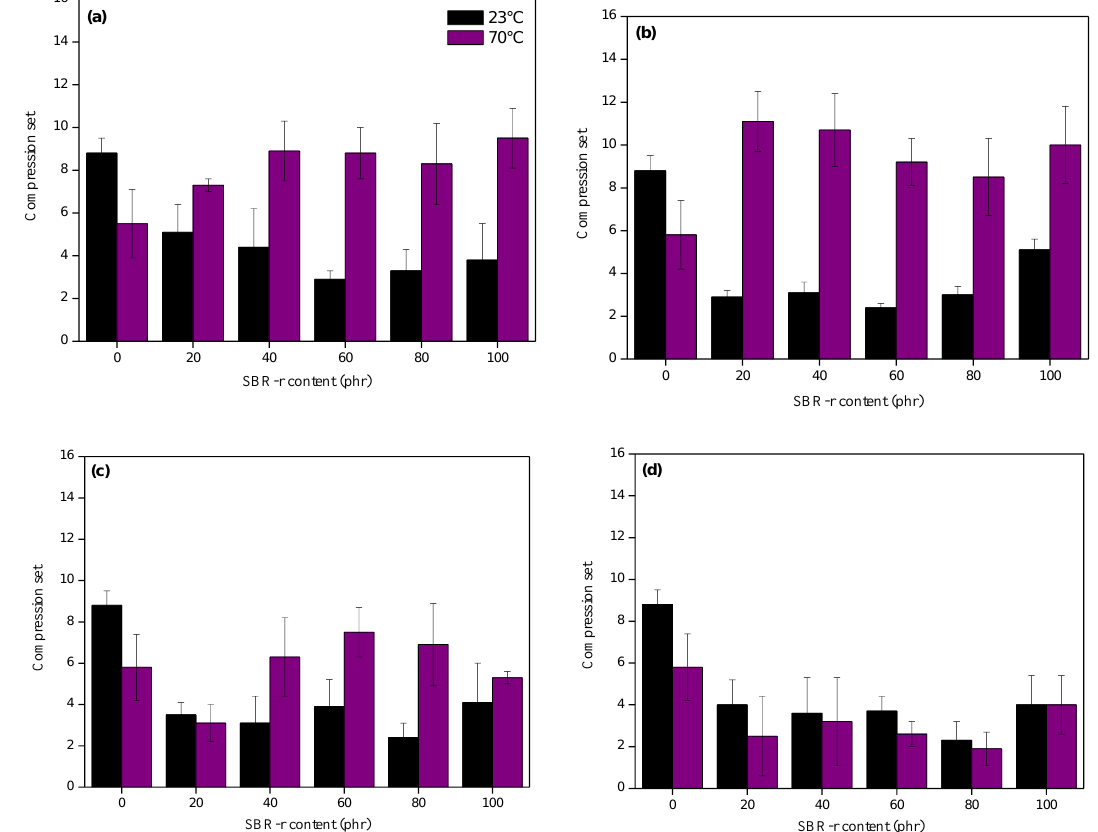
Figure 4. Compression set values of SBR-r composites before and after the accelerated aging. ( a ) SBR-0; ( b ) SBR-1; ( c ) SBR-2; and ( d ) SBR-3.